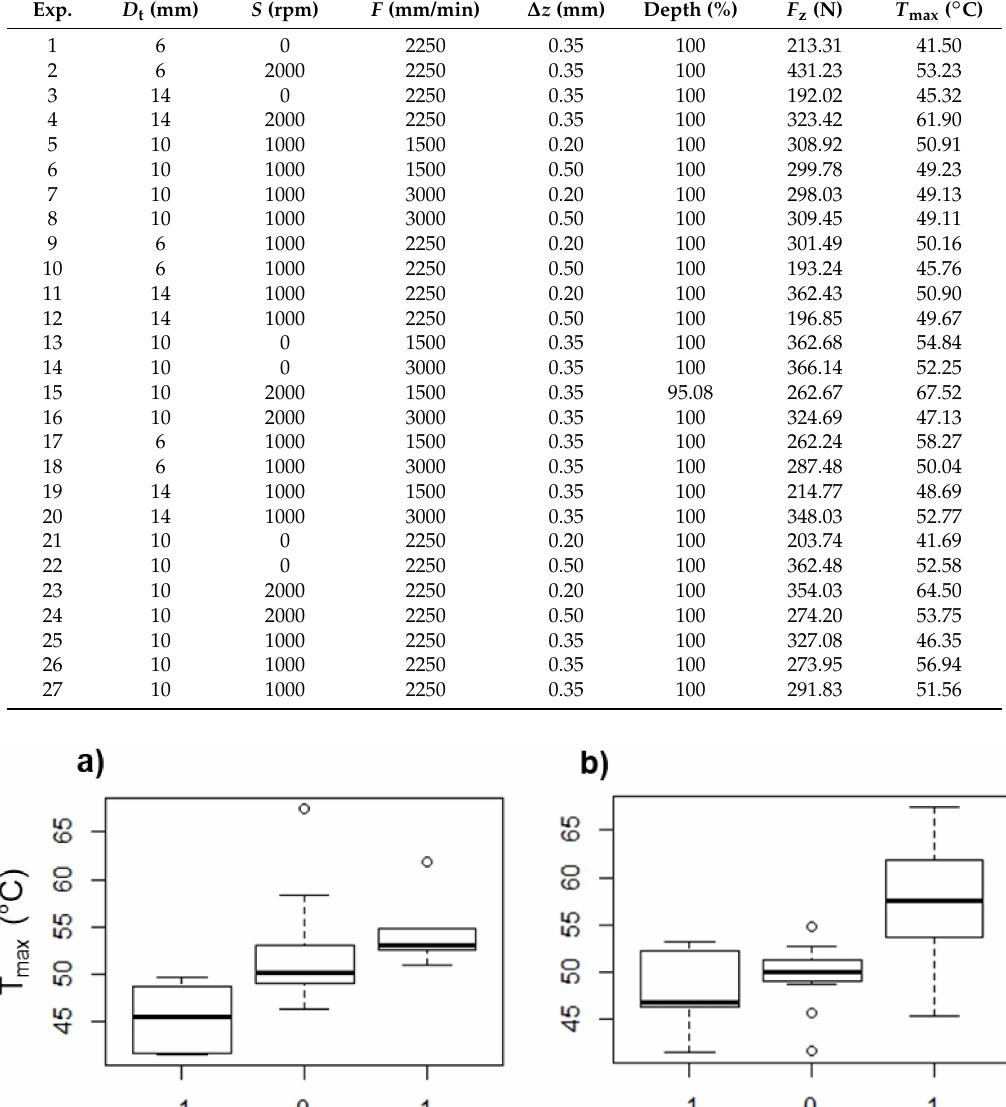
Table 5. SPIF results of PCL sheets.